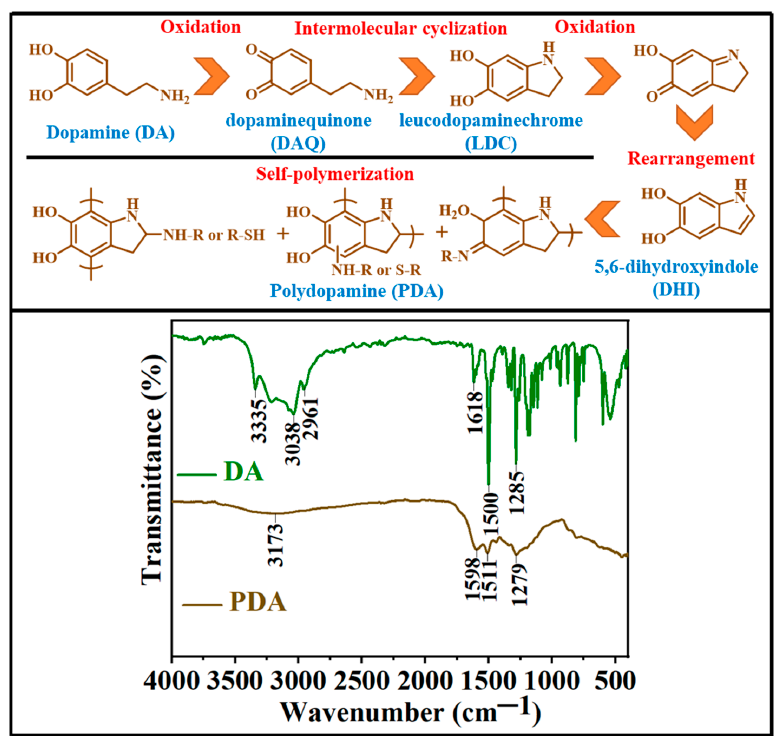
Figure 2. FTIR spectra of dopamine hydrochloride (DA) and polydopamine (PDA) coating were obtained. The upper section of the figure represents the oxidation of dopamine to polydopamine (from right to left and then bottom with black lines separating the different structures).